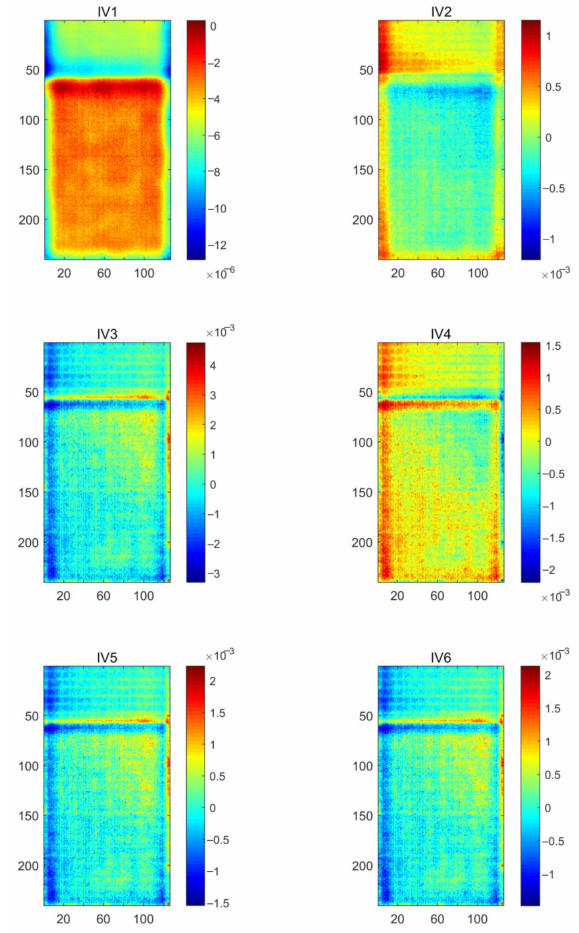
Figure 12. LLE analysis